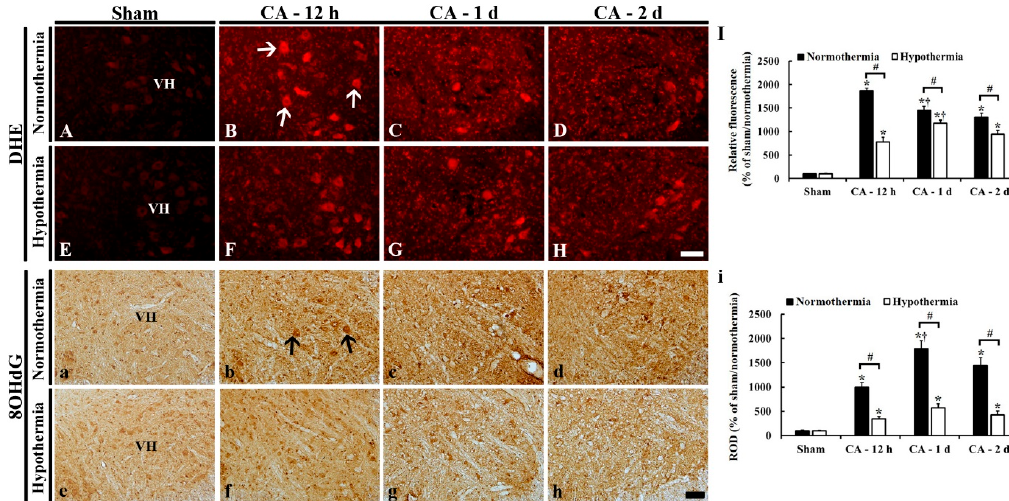
Figure 5. DHE fluorescence staining ( A – H ) and 8OHdG immunohistochemistry ( a – h ) in the lumbar ventral horn of the sham / normothermia ( A ), ACA / normothermia ( B – D ), sham / hypothermia ( E ), and ACA / hypothermia ( F – H ) groups. In the ACA / normothermia group, DHE fluorescence (arrows) and 8OHdG immunoreactivity (arrows) are significantly increased compared to that in the sham / normothermia, showing that each level is the highest at 12 h and 1 day, respectively, after ACA. However, in the ACA / hypothermia group, DHE fluorescence and 8OHdG immunoreactivity are significantly lower than that in the ACA / normothermia group. VH, ventral horn. Scale bar = 100 µ m. ( I,i ) Relative DHE fluorescence ( I ) and ROD as % of 8OHdG immunoreactive structures ( i ) in the lumbar ventral horn. The bars indicate the means ± SEM ( n = 5 and 7 for the sham and ACA groups; * p < 0.05 vs. each sham group; # p < 0.05 vs. the ACA / normothermia group; † p < 0.05 vs. the previous time-point